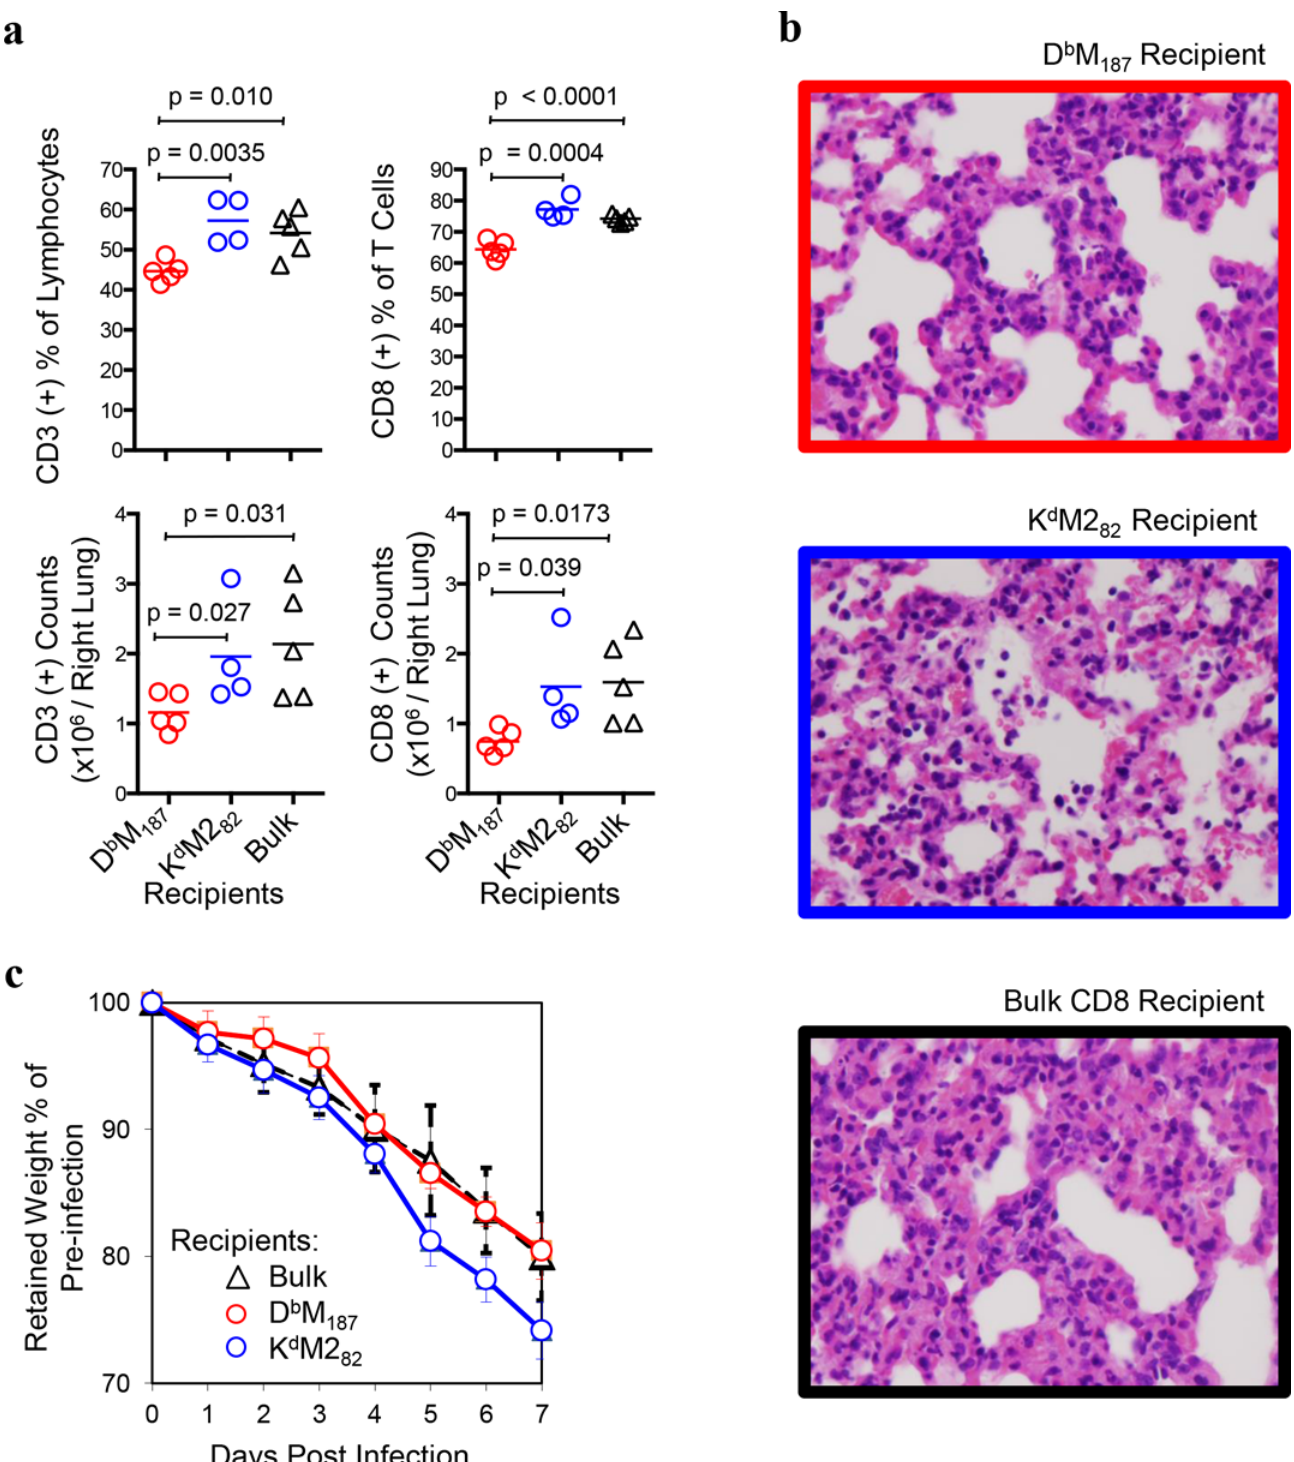
Fig 8. The D b M 187 T cells provide protection with limited pulmonary inflammation and illness of the recipients. The D b M 187 , K d M2 82 and bulk CD8 T cell recipients were challenged with RSV (a) Inflammatory cells were assessed at 7 dpi with flow cytometry. The absolute number and frequency of CD3 (+) cells and CD8 (+) T cells are expressed as mean with independent data point and are compared by Student ’ s t -test. Data represent 3 independent experiments (n = 5/group/experiment). Each symbol represents one mouse. ( b ) Pathology of lung. Left lung of the virus-challenged recipients were studied